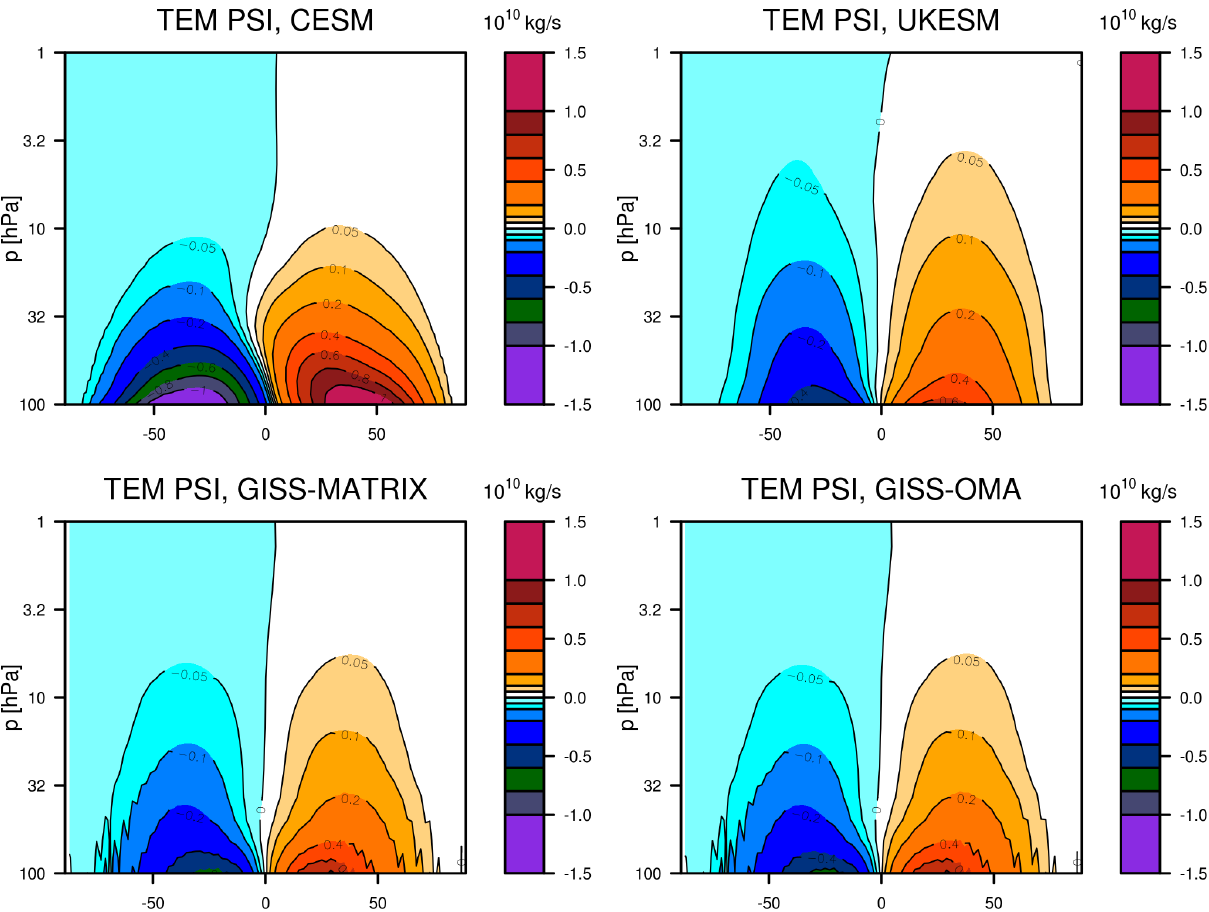
Figure 2. Climatological mass streamfunction of the residual circulation averaged over 2035–2064 in the control SSP2–4.5 for each of the four